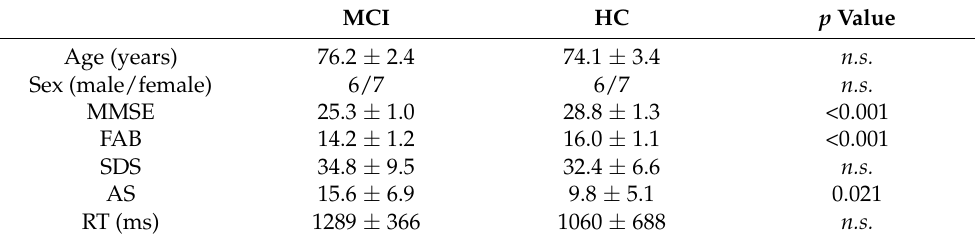
Table 1. Demographic and behavioral data in the MCI and HC groups.